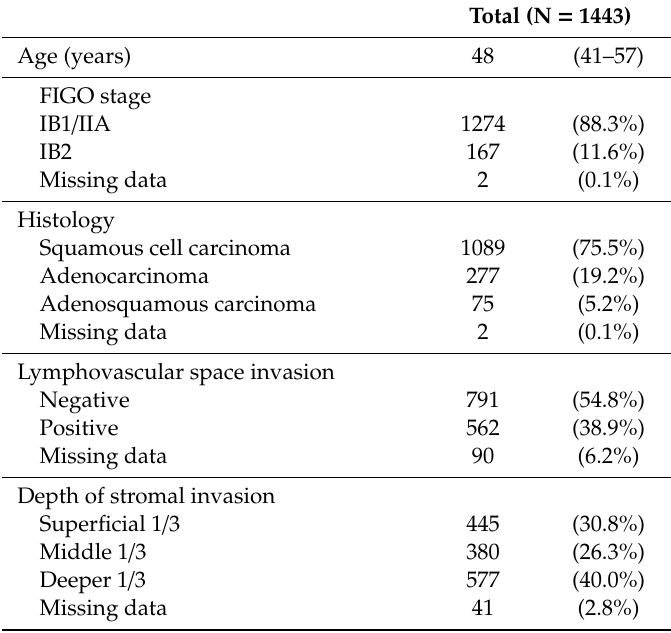
Table 1. Descriptive statistics of the